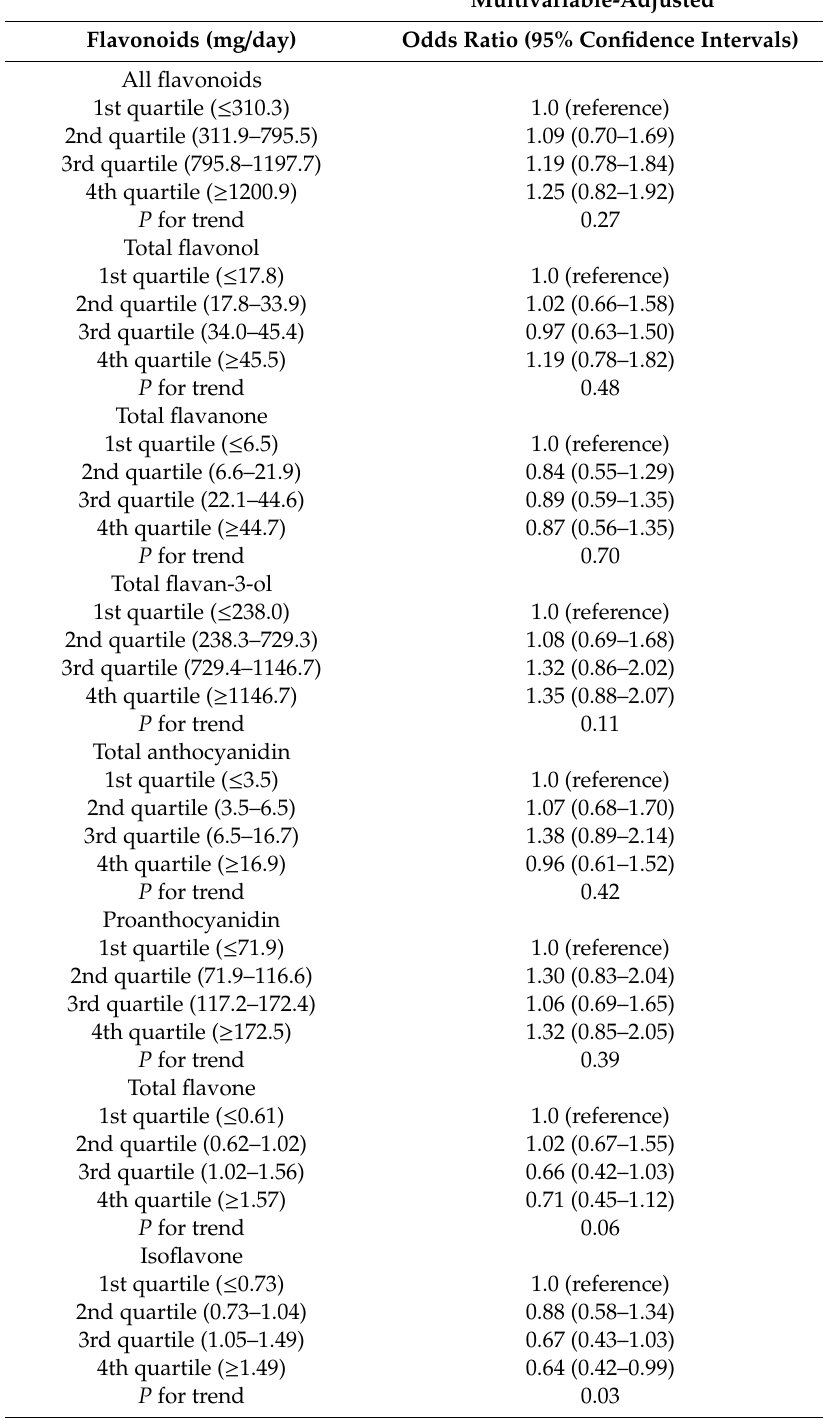
Table 2. Multivariable adjusted associations between baseline flavonoid intake and 10-year incidence of bilateral age-related hearing loss ( > 25 dB hearing level